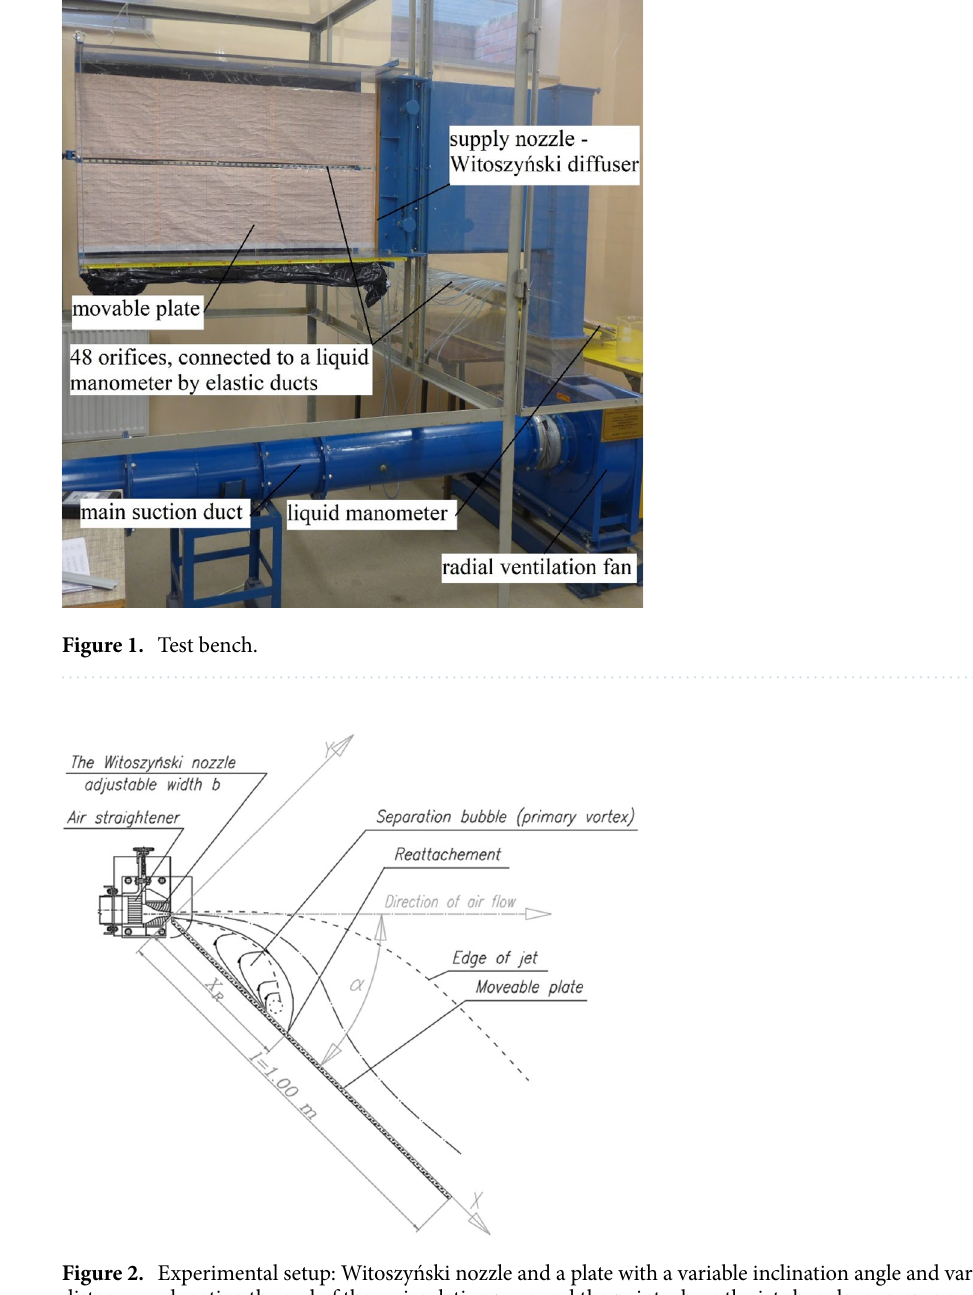
Figure 2. Experimental setup: Witoszyński nozzle and a plate with a variable inclination angle and variable distance x R denoting the end of the recirculation zone and the point where the jet shear layer grazes over the plate surface—view from the